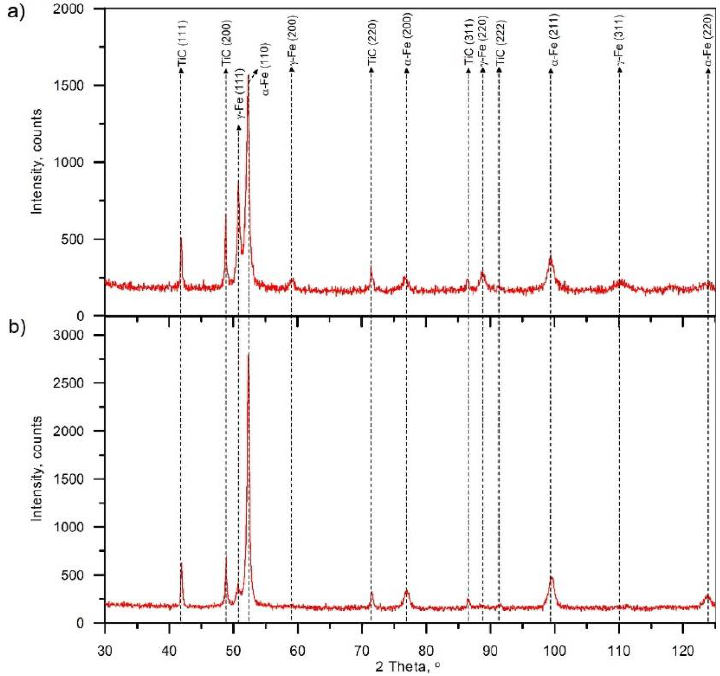
Figure 7. X-ray diffraction (XRD) patterns of ( a ) TRC and ( b ) TRM (Table 3).